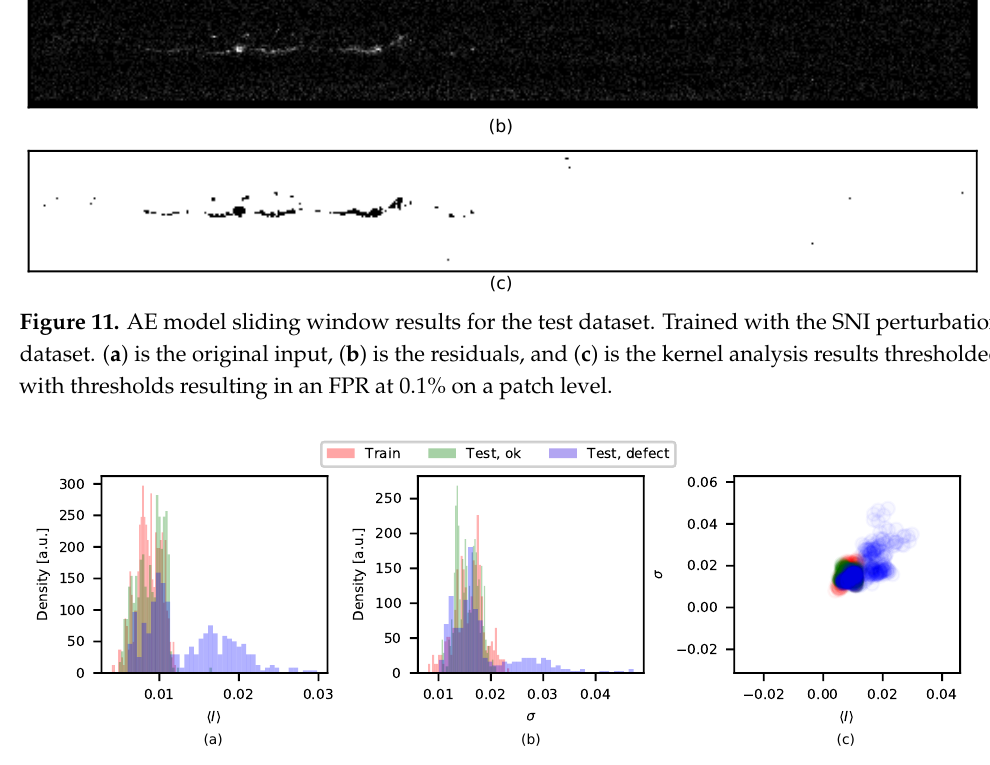
Figure 12. Kernel residual analysis results for the AE model trained on accepted welds as well as those with defects, but without any perturbation dataset. The (cid:104) I (cid:105) distribution is given in ( a ), the σ distribution in ( b ), and in ( c ) σ versus (cid:104) I (cid:105) is plotted.